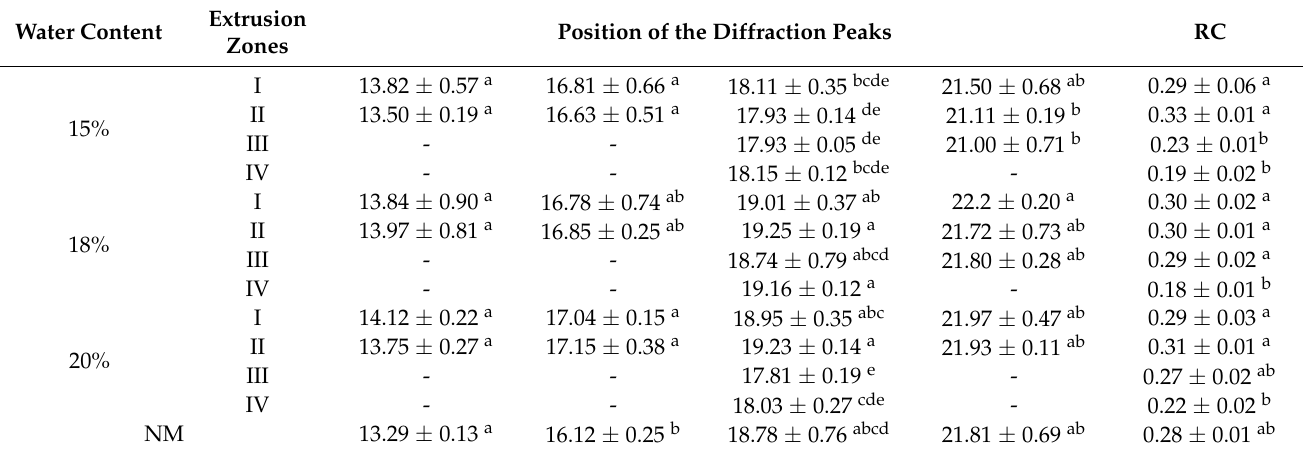
Table 2. Positions of the diffraction peaks for oats in different extrusion zones and moisture content.